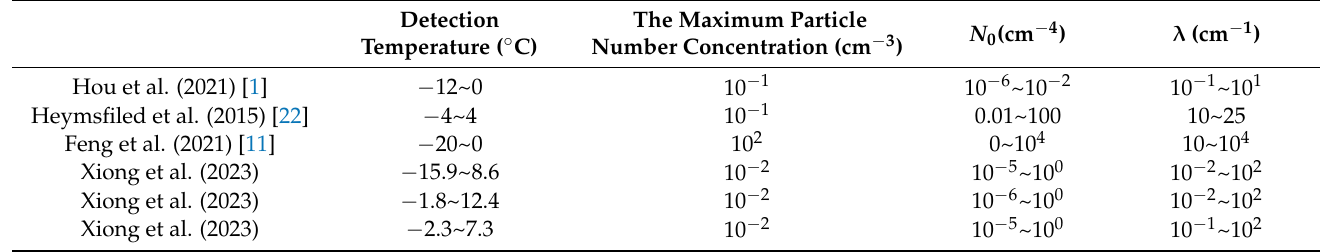
N 0 (cm − 4 ) λ (cm − 1